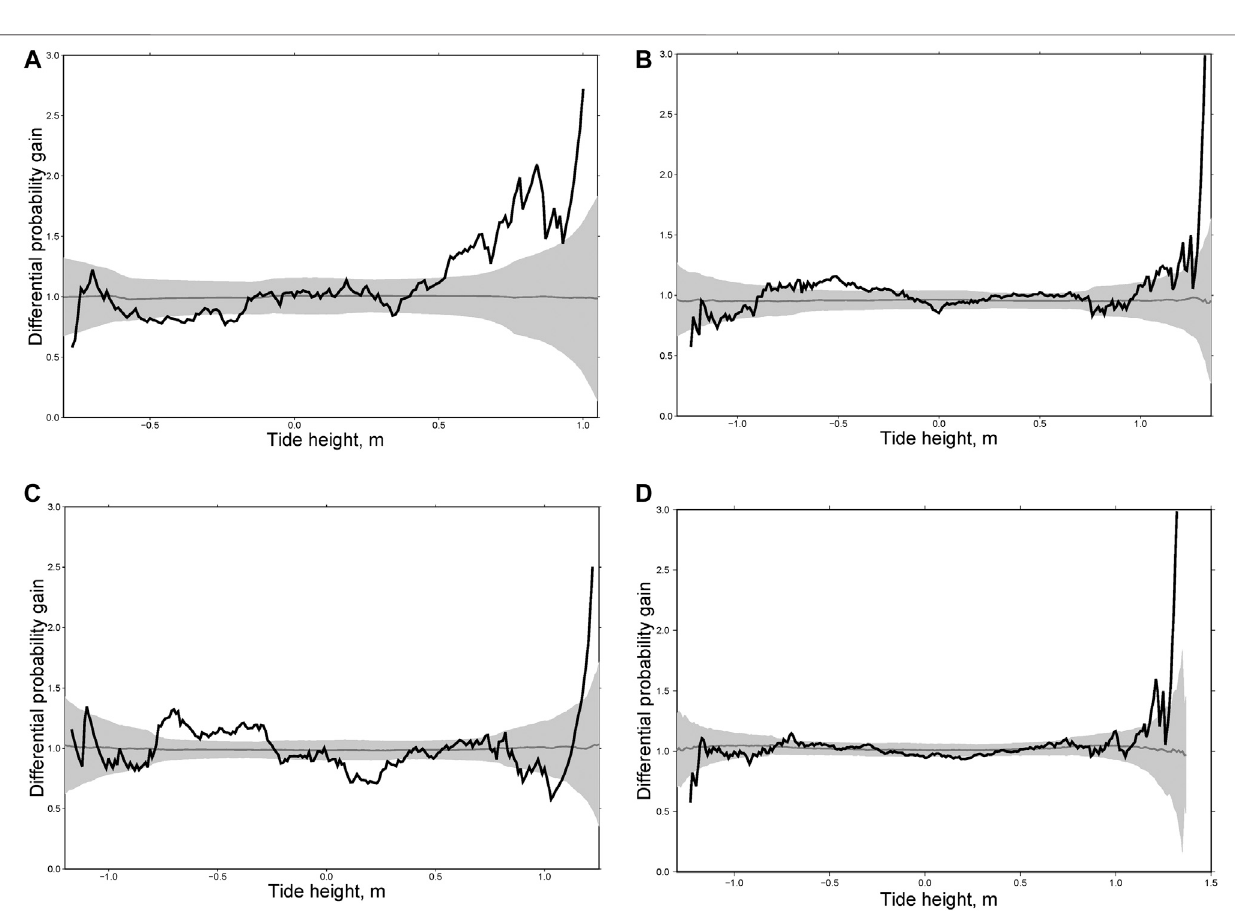
Frontiers in Earth Science |